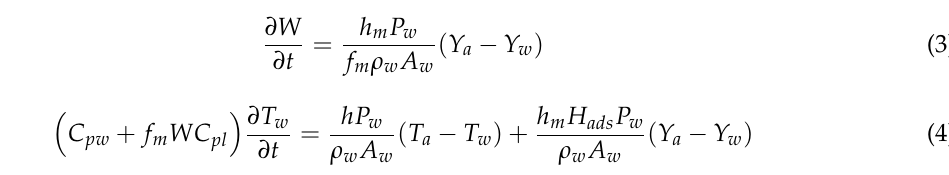
Figure 2. The heat pipe-based desiccant device in the study; ( a ) the prototype showing the adsorption/desorption zone with tablets of silica gel on the plate fin, in addition to the other waste heat recovery zone; and ( b ) its working principle